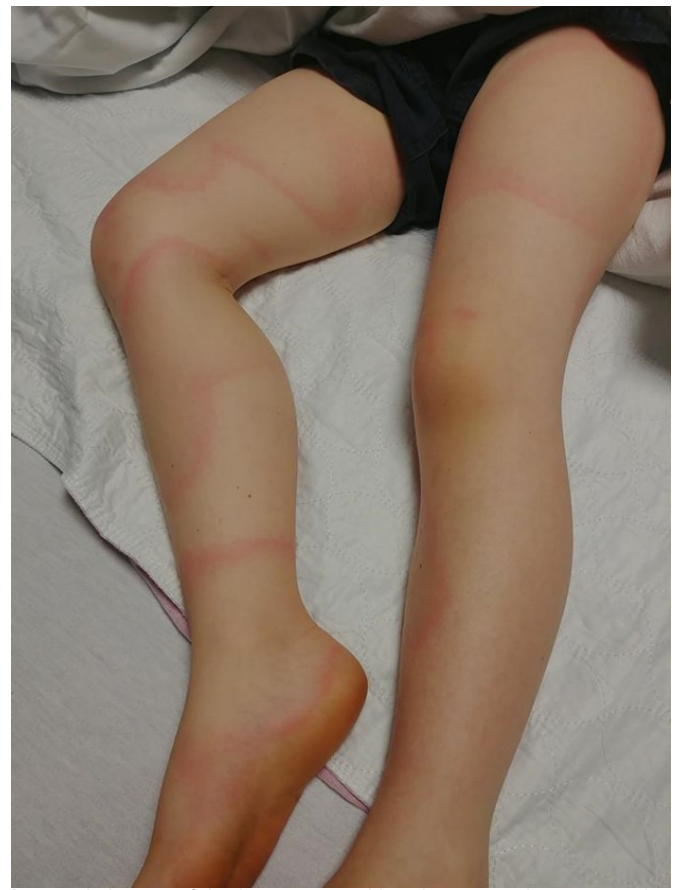
Image 2. Image of the lower extremities demonstrating an annular rash similar to the rash present on the